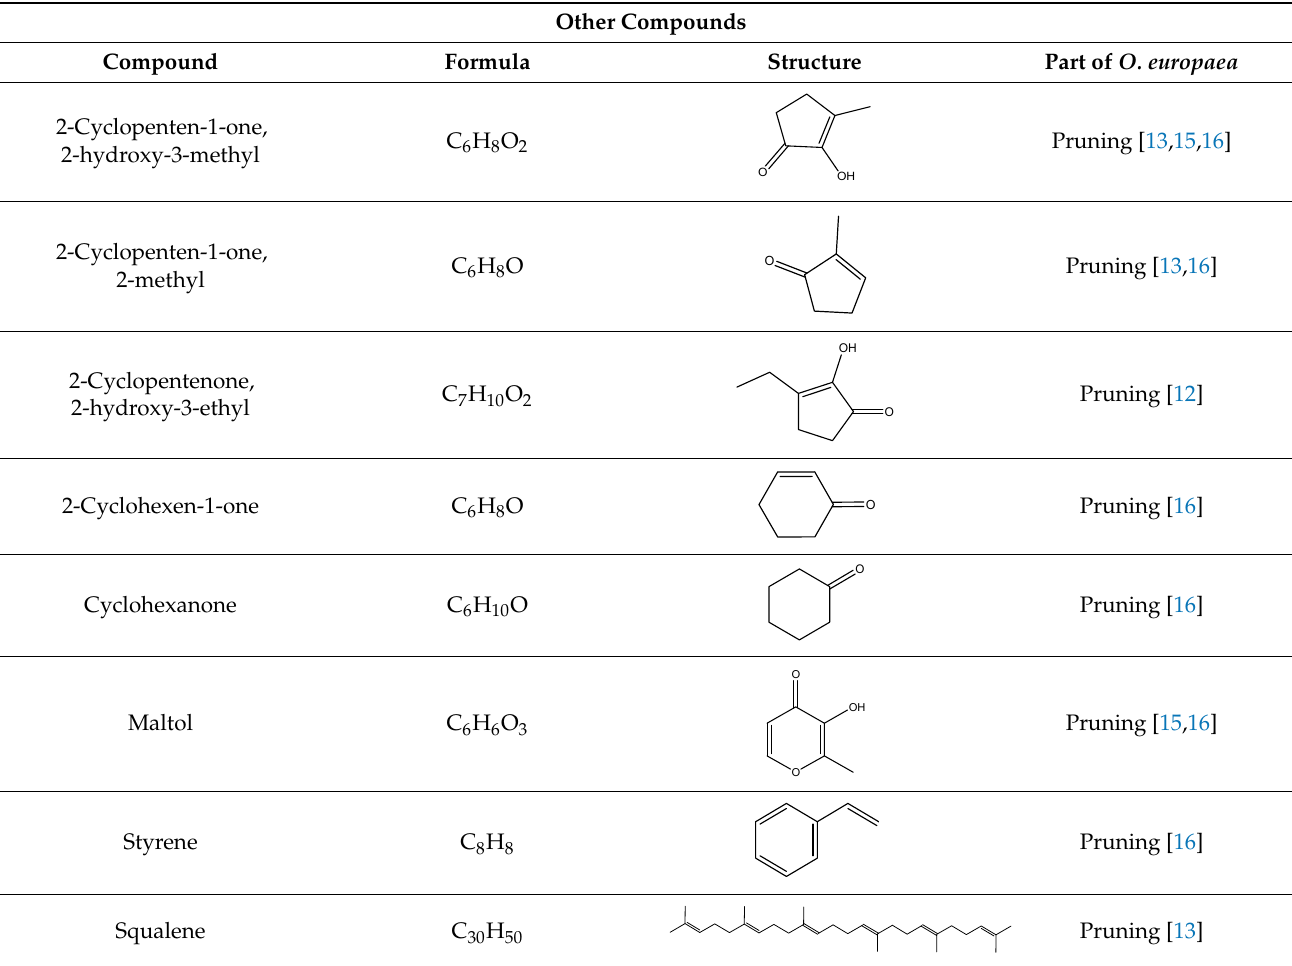
Table 1. Cont. Other Compounds Formula Structure Part of O.